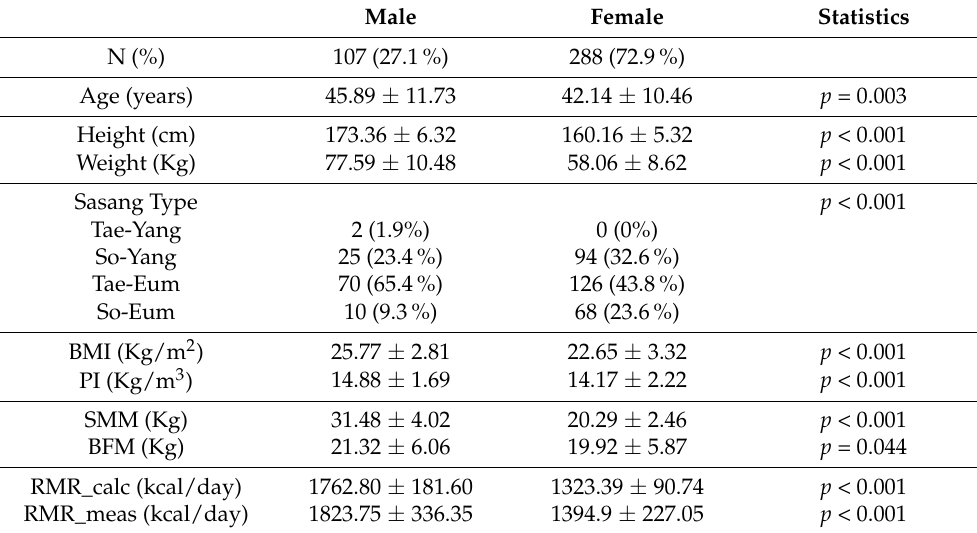
Table 1. Demographic features of the current